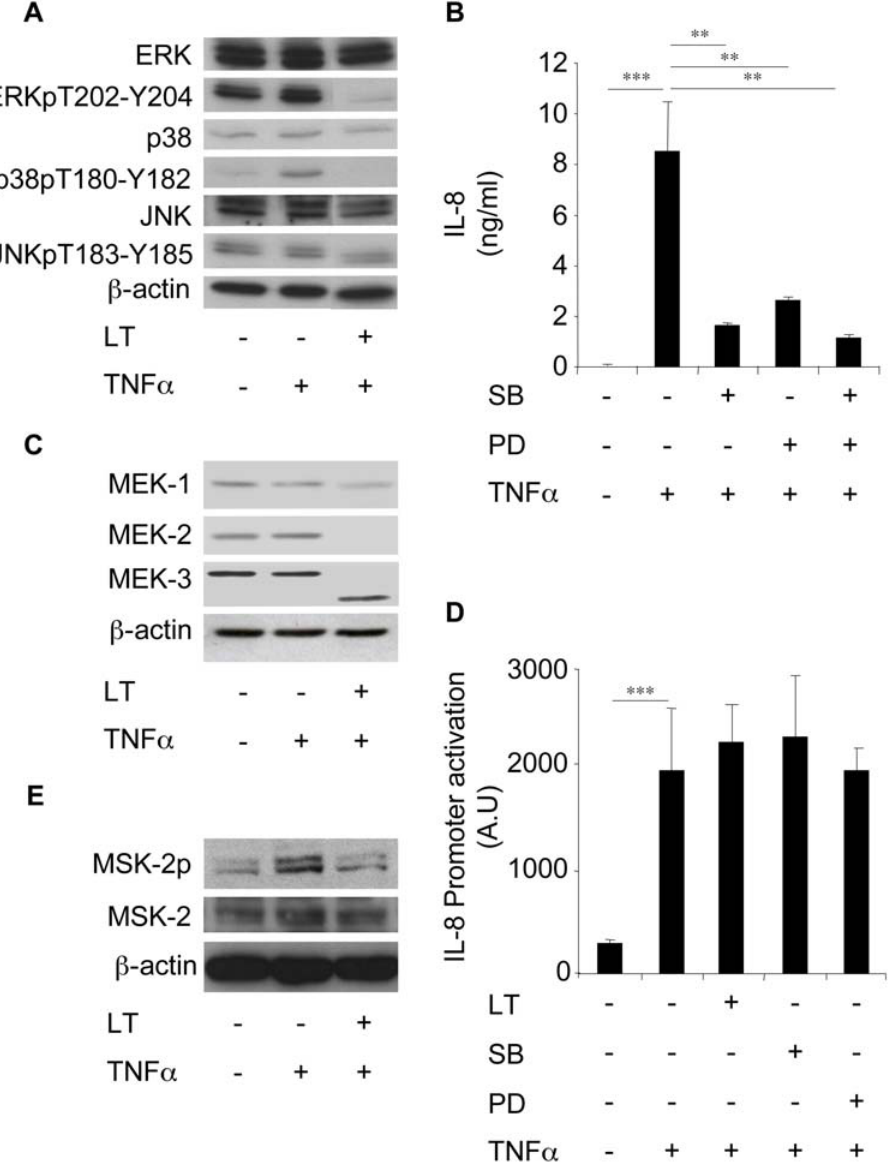
Figure 4. LT inhibits IL-8 expression via a MAPK-dependent pathway in Beas-2B cells. (A) Beas-2B cells were incubated for 1 h with LT (1 m g/ml) and stimulated with TNF a (10 ng/ml) for an additional 2 h. Western blot analyses were performed using antibodies directed against ERK, phospho-ERK (ERKpT202-Y204), p38, phospho-p38 (p38pT180-Y182), JNK, and phospho-JNK (JNKpT183-Y185) and were normalized with ß-actin antibody. (B) Cells were pretreated with SB203580 (10 m M) or PD98059 (10 m M) for 1 h before incubation with TNF a (10 ng/ml). IL-8 concentrations were measured in supernatants after 24 h stimulation. (C) Cells were incubated for 1 h with LT (1 m g/ml) and stimulated by TNF a (10 ng/ml) for an additional 2 h. Western blot analyses were performed using antibodies directed against MEK-1, MEK-2, and MEK-3 and were normalized with ß-actin antibody. (D) Cells were transfected with an IL-8 promoter reporter plasmid, and then incubated for 1 h with LT (1 m g/ml), SB203580 (10 m M), or PD98059 (10 m M) before addition of TNF a (10 ng/ml). Luciferase activity was then measured after 24 h stimulation. (E) Cells were incubated for 1 h with LT (1 m g/ml) and stimulated by TNF a (10 ng/ml) for an additional 45 min. Western blot analyses were performed using antibodies directed against MSK-2 and phospho-MSK-2 and normalized with ß-actin